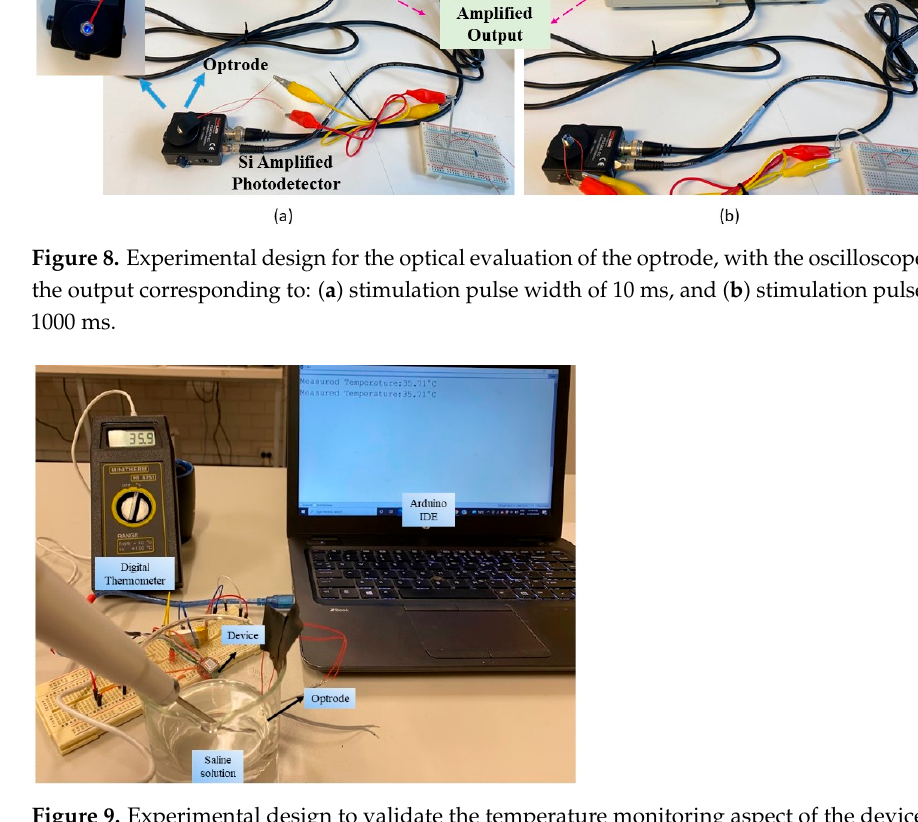
Figure 9. Experimental design to validate the temperature monitoring aspect of the device. Table 2. Comparison between the temperatures measured using a digital thermometer and the NTC sensor in saline solution.